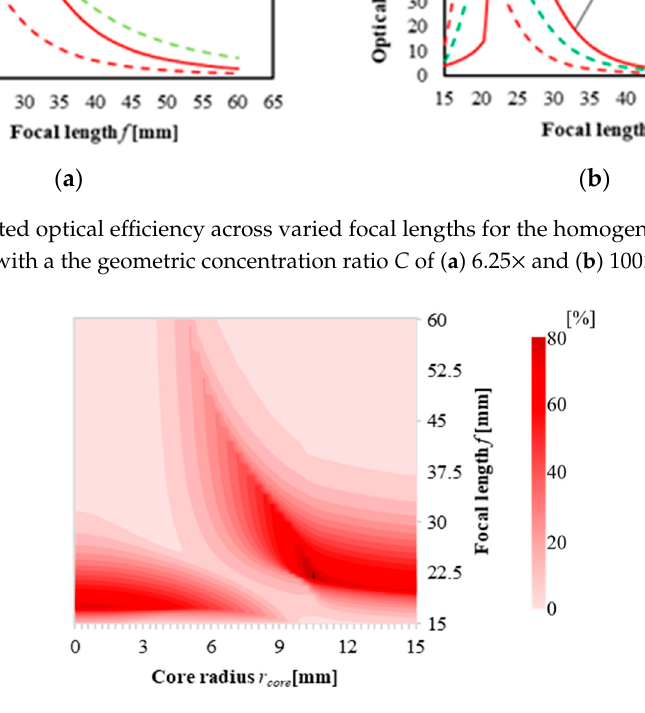
Figure 9. Simulated optical efficiency for varied core radii and focal lengths (C = 100 × ).